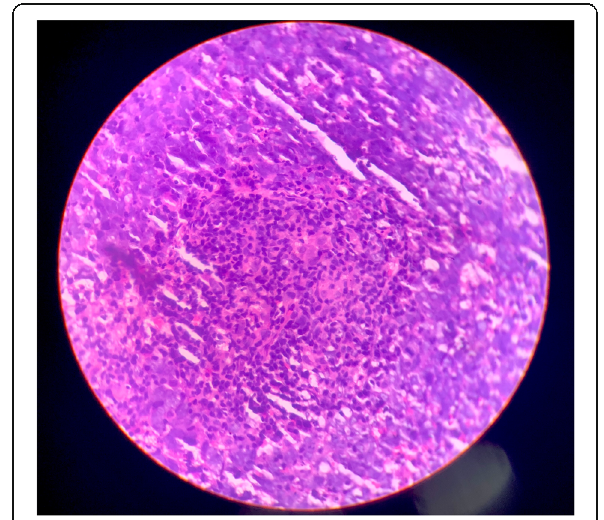
Fig. 4 HPE shows tumour composed of nests and sheets of atypical cells which are surrounding by dense lymphoplasmacytic infiltrate. Tumour cells are large with moderate pleomorphism, vesicular nucleus with prominent nucleoli and scant